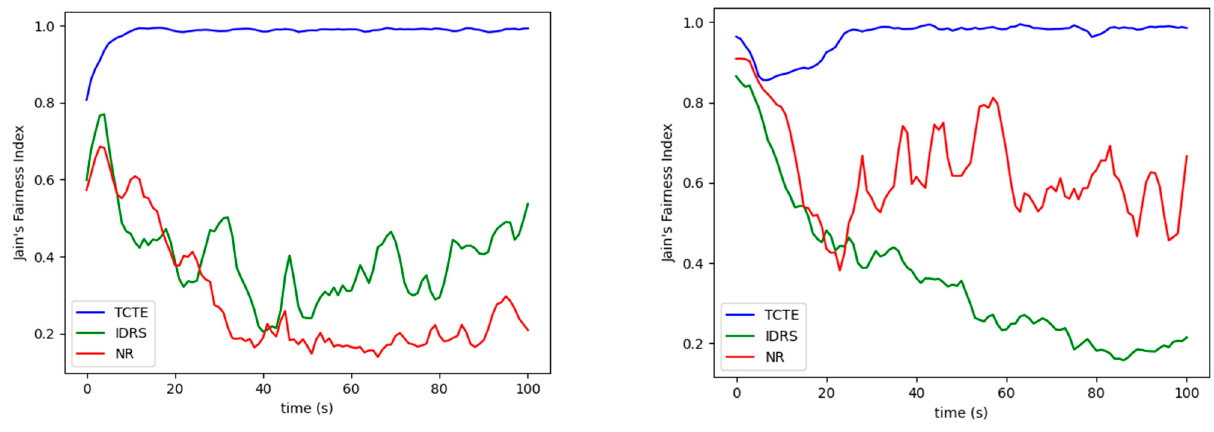
Figure 10. Variation in Jain’s Fairness Index over time.